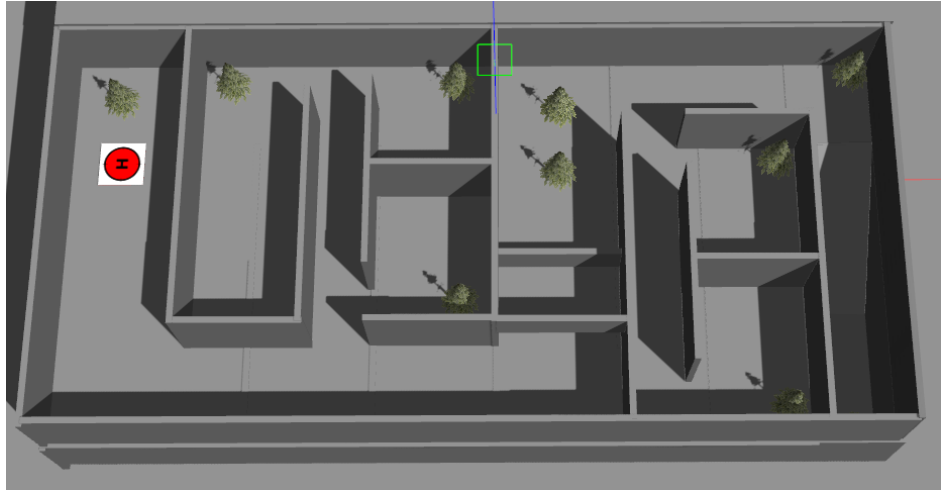
Figure 28. Unknown environment (top view of second floor). The red H is the destination location, similar to the previous